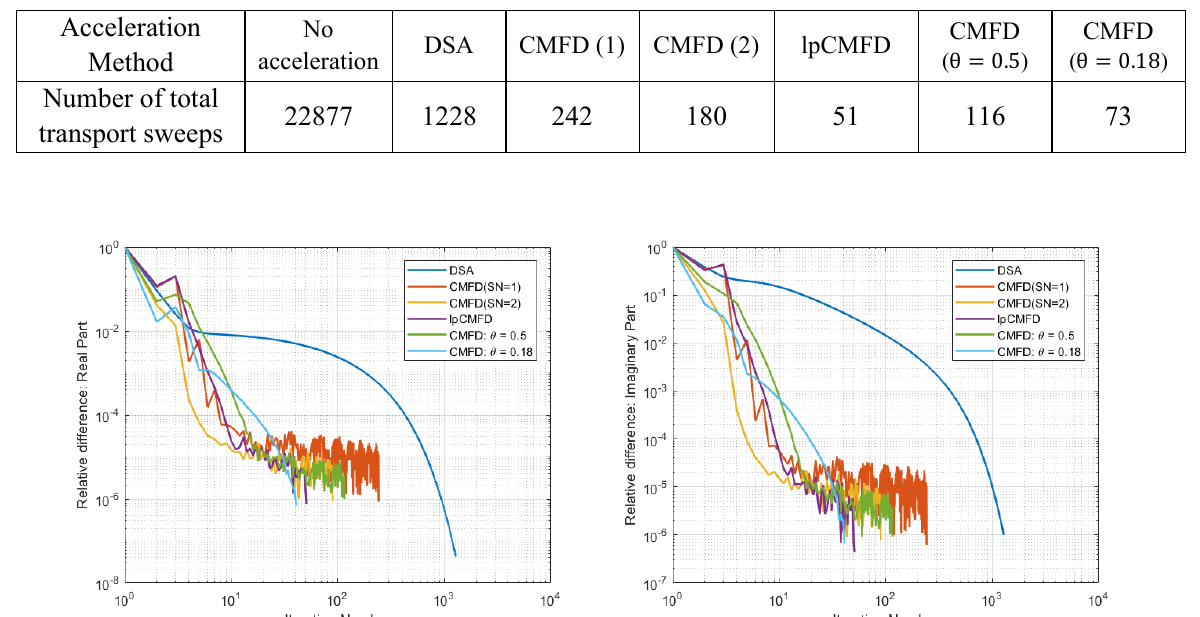
Figure 2 C3 problem - Convergence of the real (on the left) and the imaginary (on the right) part